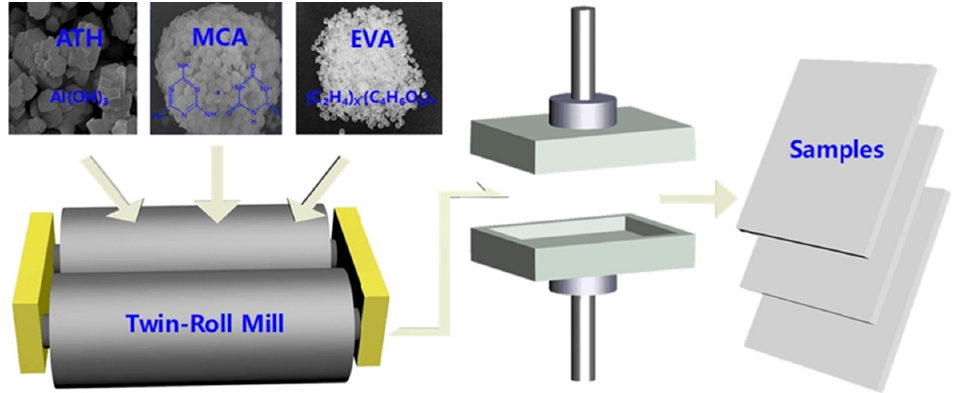
Figure 3. Schematic illustration of synthetic route of the flame retardant EVA composites [104].